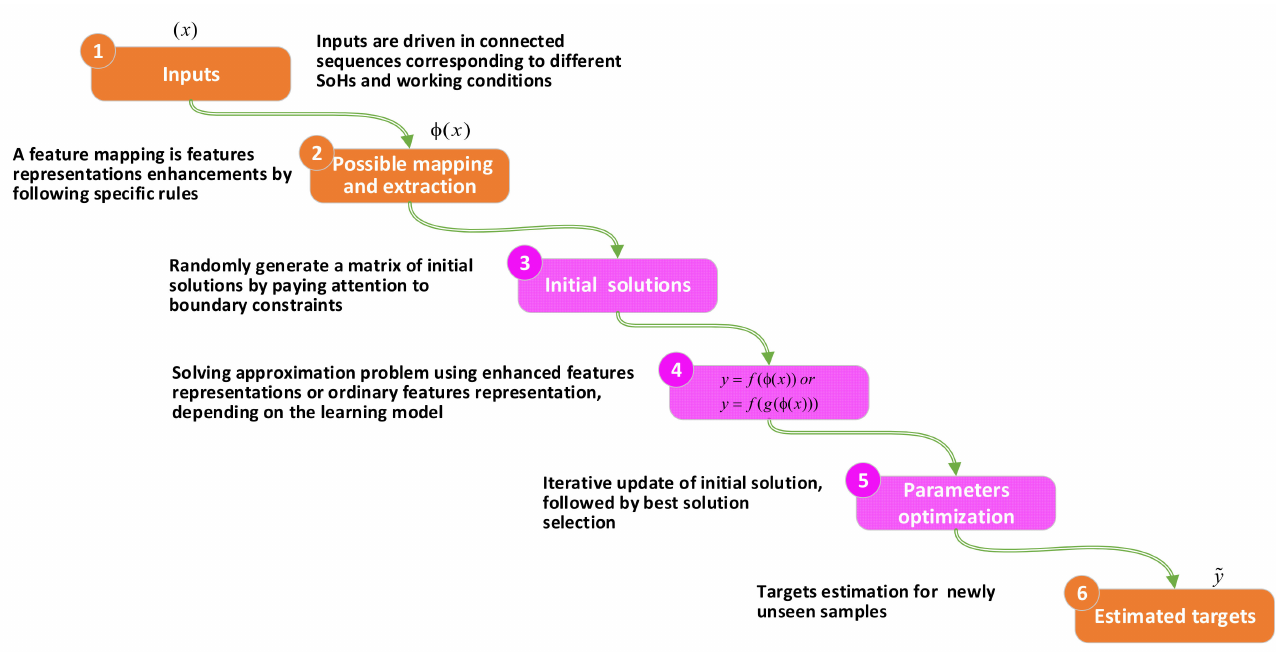
Figure 13. Overview of using ECT and SI within ML